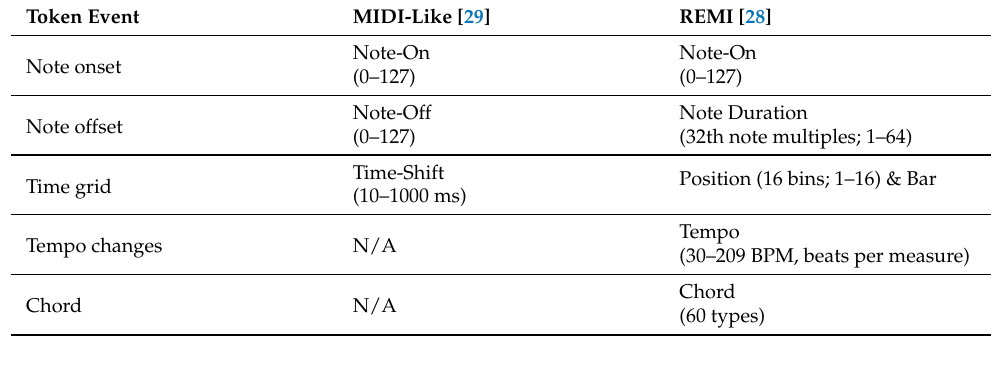
Table 2. Comparison between MIDI-like and REMI representations.